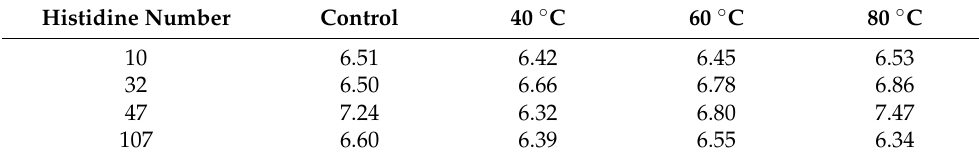
Table 4. The pKa of histidine residues of α -lactalbumin at different thermal treatments. Histidine